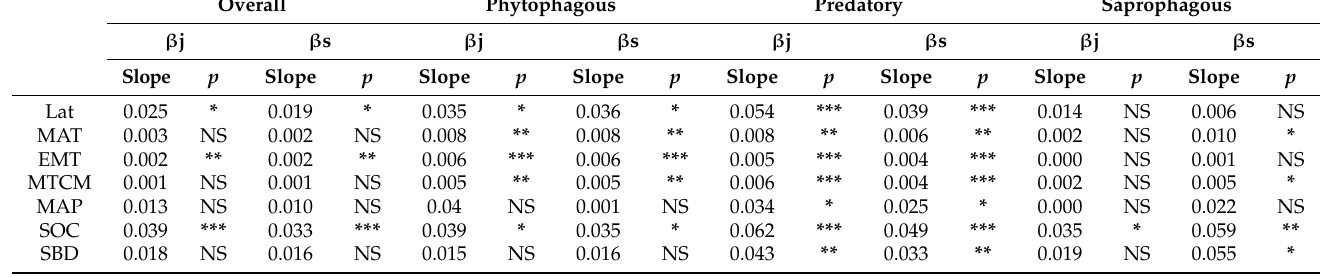
Table 6. The rate of dissimilarity among order composition across all possible plot pairs along the spatial or environmental gradient in East Asia. The “*”, “**”, “***” and “NS” represent p ≤ 0.05, 0.01, 0.001 and p > 0.05, respectively. (Note: Lat = latitude, MAT = mean annual temperature, MTCM = mean temperature of the coldest months, EMT = extreme minimum temperature, MAP = mean annual precipitation, SOC = soil organic carbon and SBD = soil bulk density.).